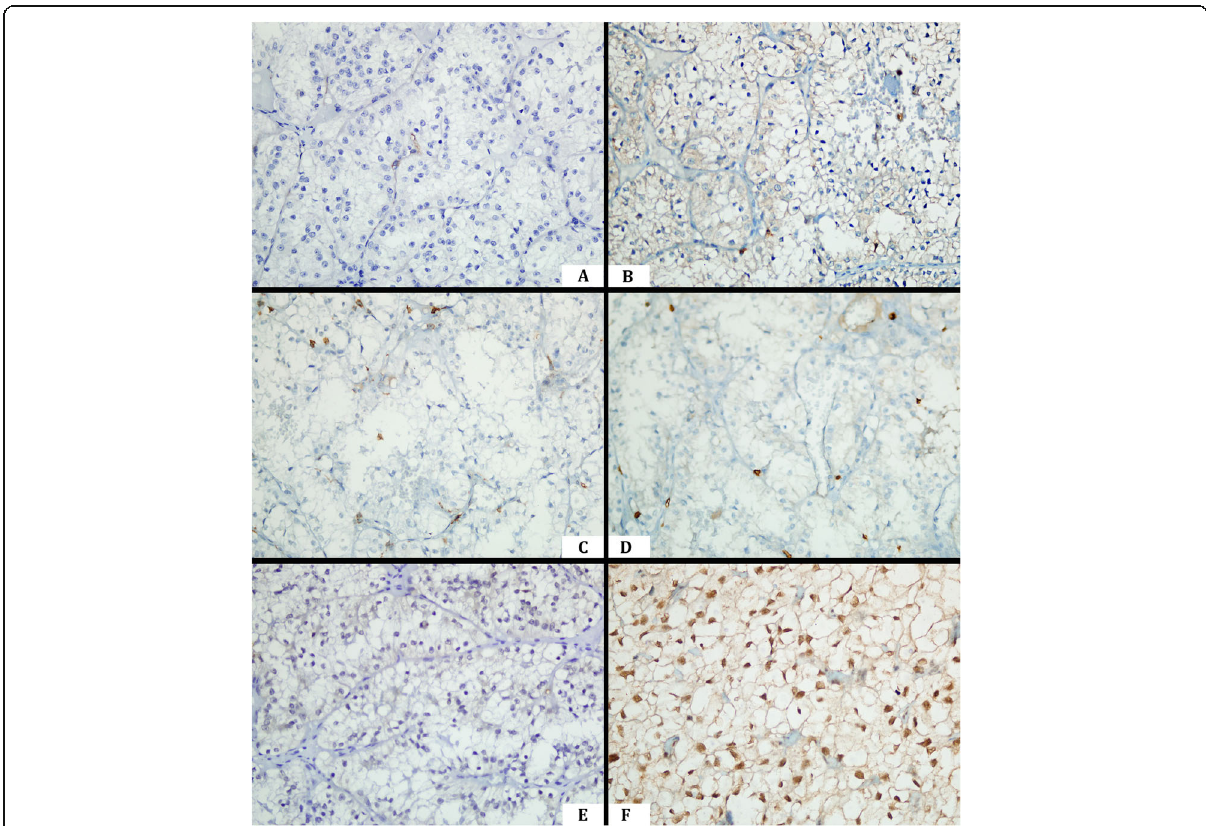
Fig. 3 A PD-L1 negative case with a mild lymphocyte density, low HIF-2 α expression, and high HIF-1 α expression (× 400). a No PD-L1 staining. b PD-1-positive mild lymphocytic infiltration, c CD4-positive mild lymphocytic infiltration. d CD8-positive mild lymphocytic infiltration, e Negative HIF-2 α expression. f High-score HIF-1 α